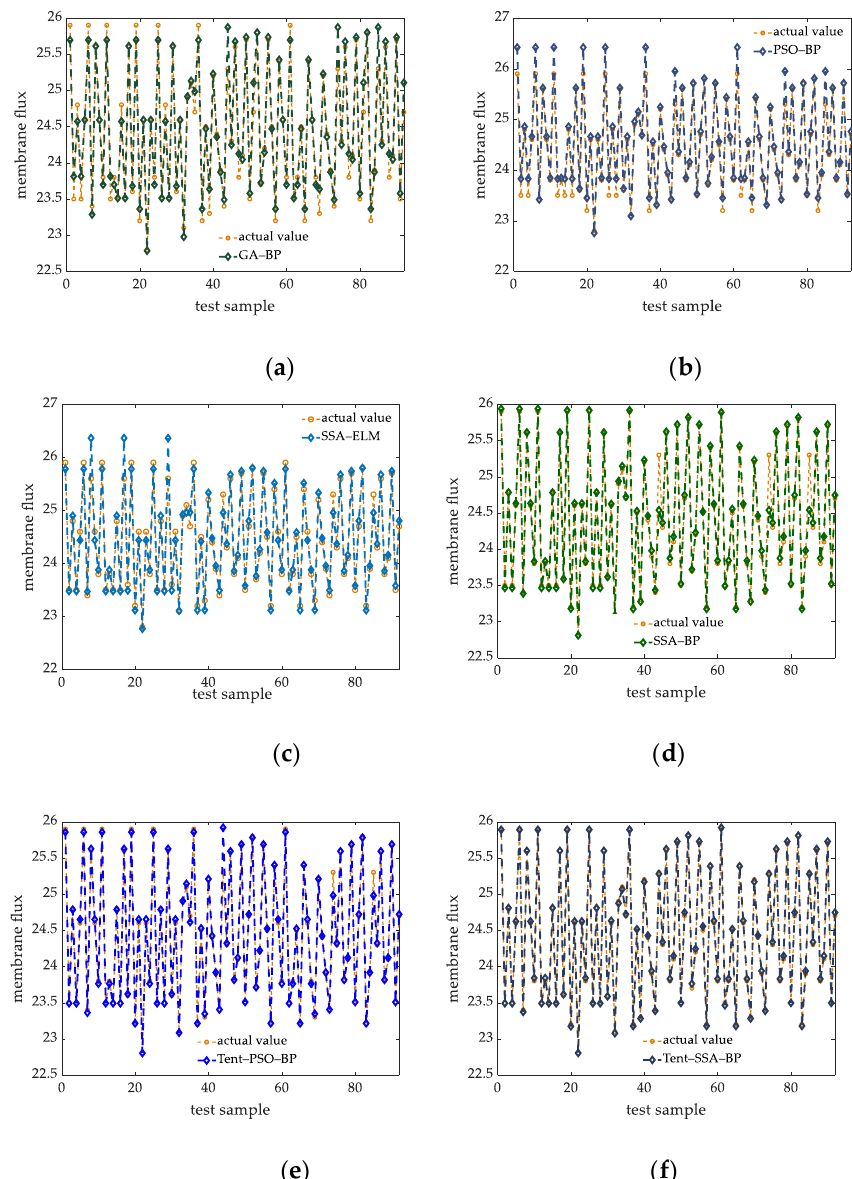
Figure 8. Prediction results of different soft measurement models. ( a ) GA-BP prediction contrast map. ( b ) PSO-BP prediction contrast map. ( c ) SSA-ELM prediction contrast map. ( d ) SSA-BP prediction contrast map. ( e ) Tent-PSO-BP prediction contrast map. ( f ) Tent-SSA-BP prediction contrast map.